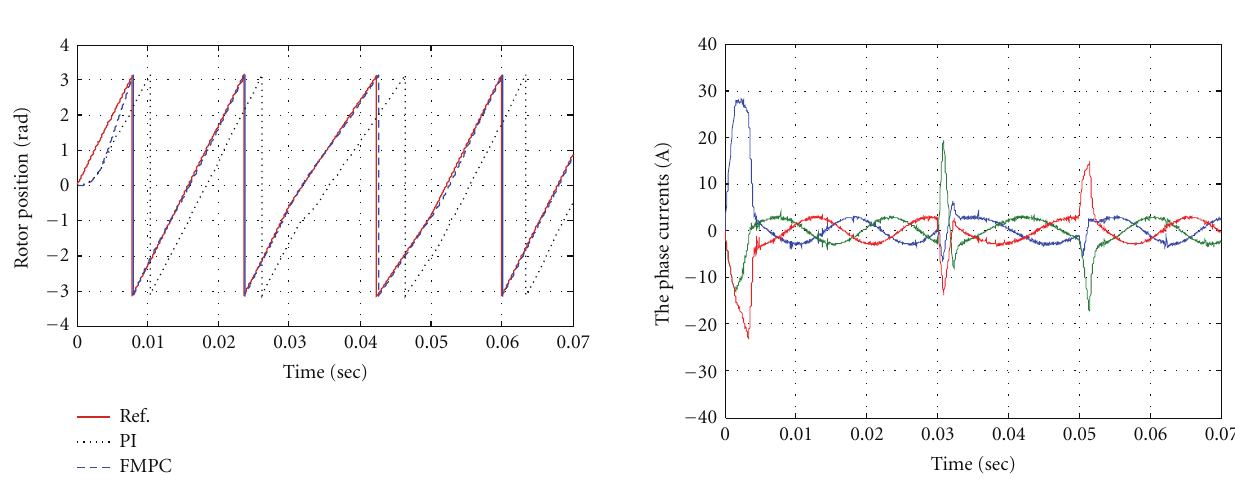
Figure 6: Stator current response of the PMSM system based on the FMPC